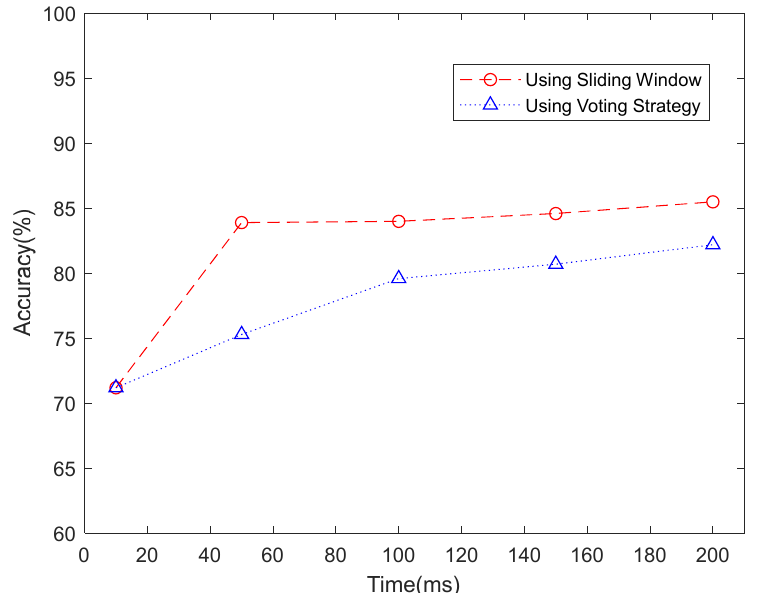
Figure 7. Recognition accuracy comparison between using sliding window and voting strategy in NinaPro DB1.